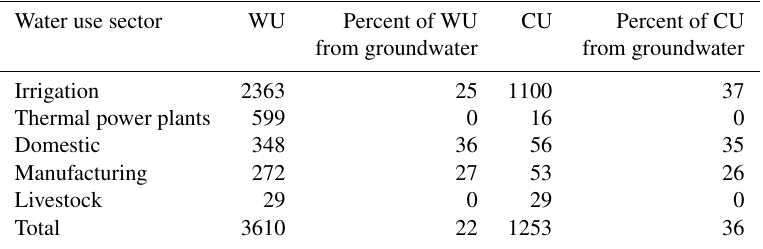
Table 8. Globally aggregated (excluding Antarctica and Greenland) sectoral potential withdrawal water use WU and consumptive water use CU (km 3 yr − 1 ) as well as use fractions from groundwater (%) as simulated by GWSWUSE of WaterGAP 2.2d for the time period 1991– 2016. These values represent demands for water that cannot be completely satisfied in WGHM due to lack of surface water resources (row 5 in Table